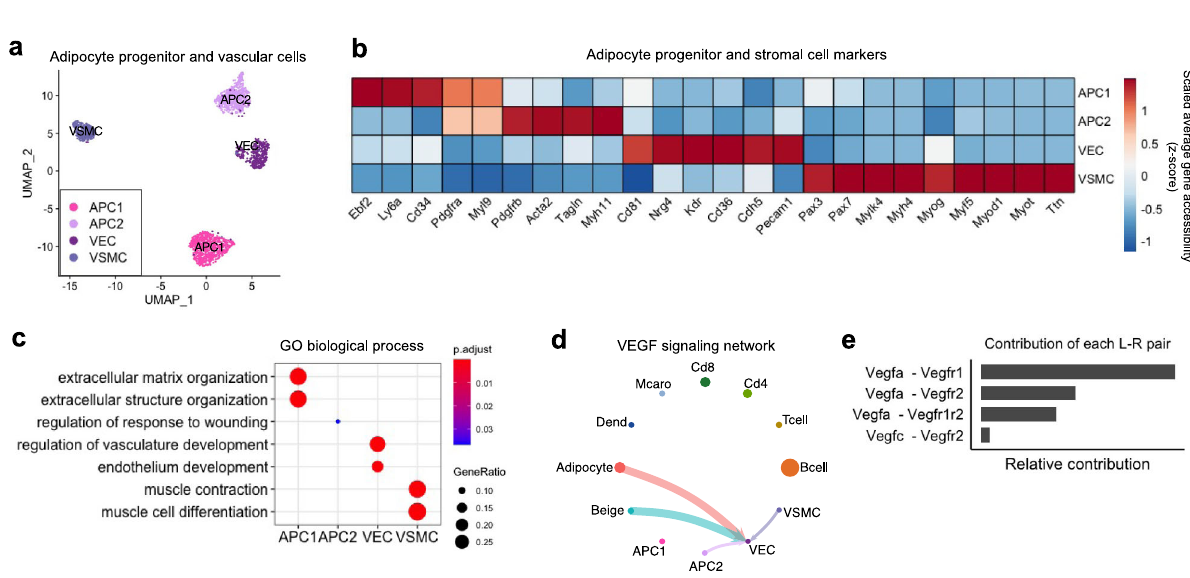
Fig. 5 Cell – cell interaction for vasculature development. a UMAP plot of adipocyte progenitor and vascular endothelial and smooth muscle cells ( n = 1,861). b Heatmap of normalized gene accessibility for cell-type markers. c GO analysis using the top 100 differentially accessible genes for each cell type. d Circle plot displaying VEGF signaling network inferred by gene accessibility of ligand-receptor pairs. Circle sizes are proportional to the size of each group. The circle and line colors represent the senders. The arrows indicate the receivers that receive signal from the corresponding senders. Thicker line indicates a stronger signal interaction. e Major contributors of ligand-receptor pairs of VEGF signaling network among the senders and the receiver. APC1 Adipocyte progenitor cell 1, APC2 Adipocyte progenitor cell 2, VEC Vascular endothelial cell, VSMC Vascular smooth muscle